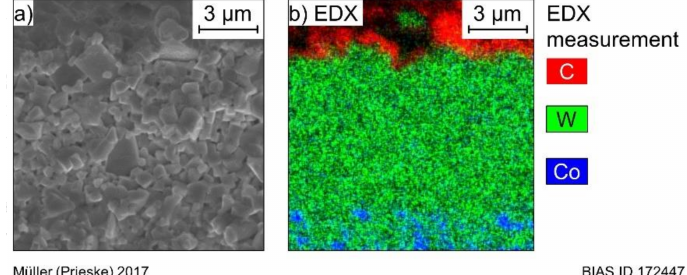
Figure 2. Cryofracture of an etched hard metal substrate coated with diamond deposited at 850 ◦ C: ( a ) SEM picture and ( b ) corresponding EDX